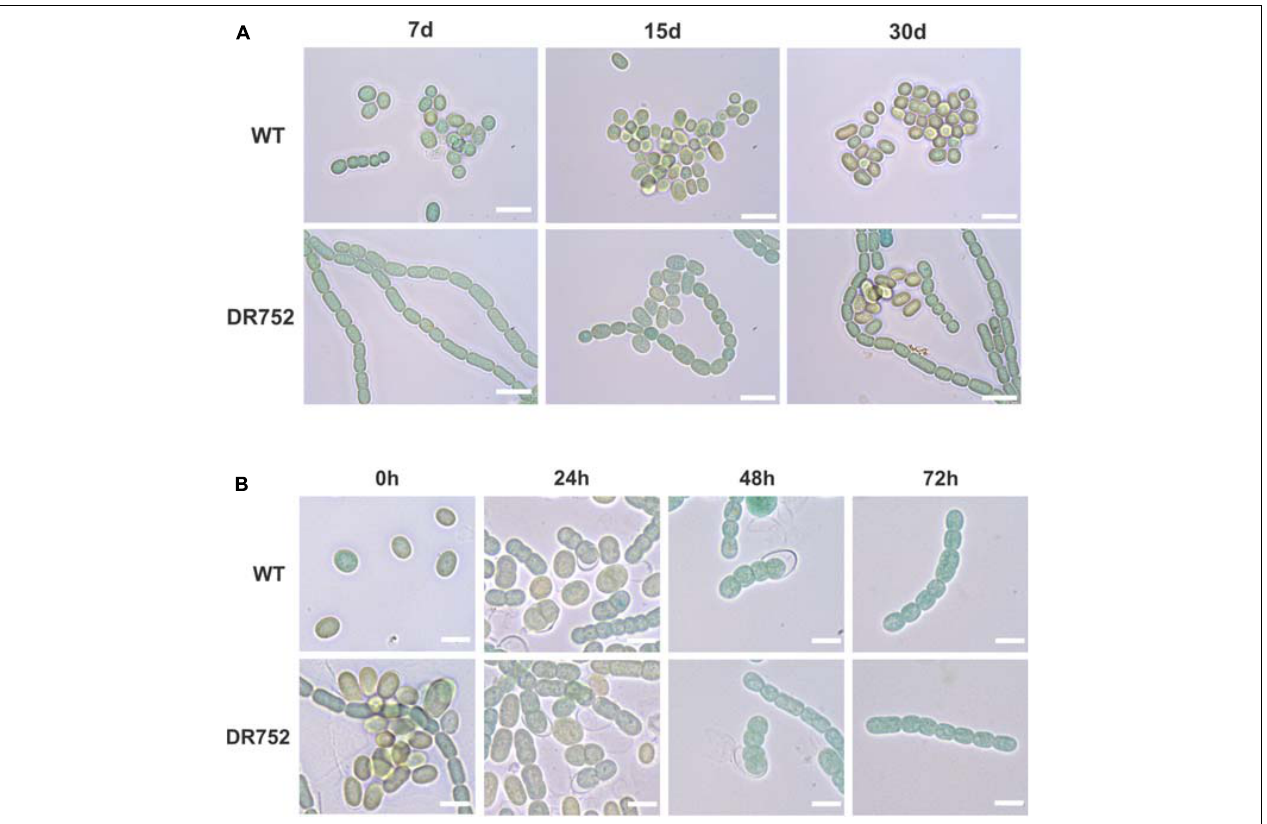
FIGURE 3 | Akinete differentiation and germination process in WT and mutant DR752. (A) Bright field micrographs of the WT and mutant DR752 culture after 7, 15, and 30 days of akinetes differentiation in low light. Bars, 10 µ m. (B) Germination of 3–4 months old mature akinetes was induced by transferring the cultures to normal light conditions and monitored by light microscopy after 0, 24, 48, and 72 h. Bars, 5 µ